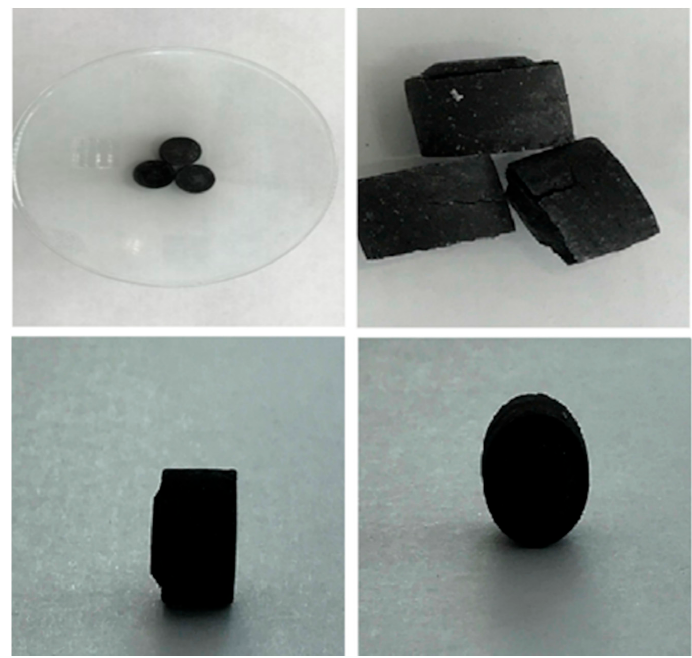
Figure 1. Sewage sludge char pellets. Table 1. Pellets physical